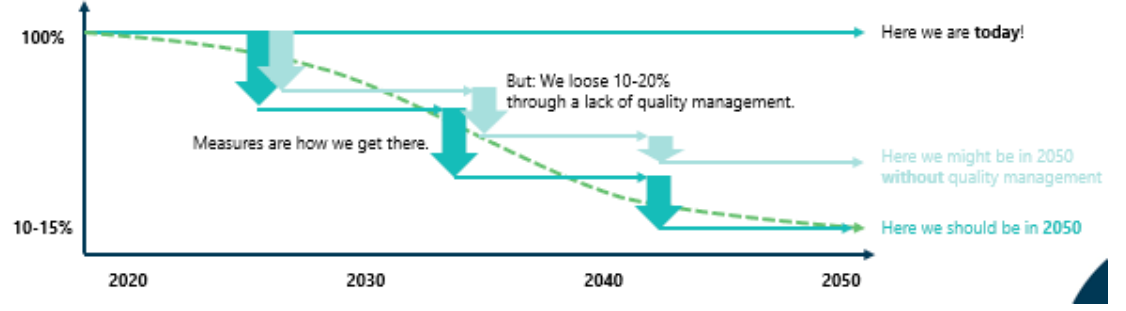
Figure 3. Quality management service: the key to meet ESG goals in the building